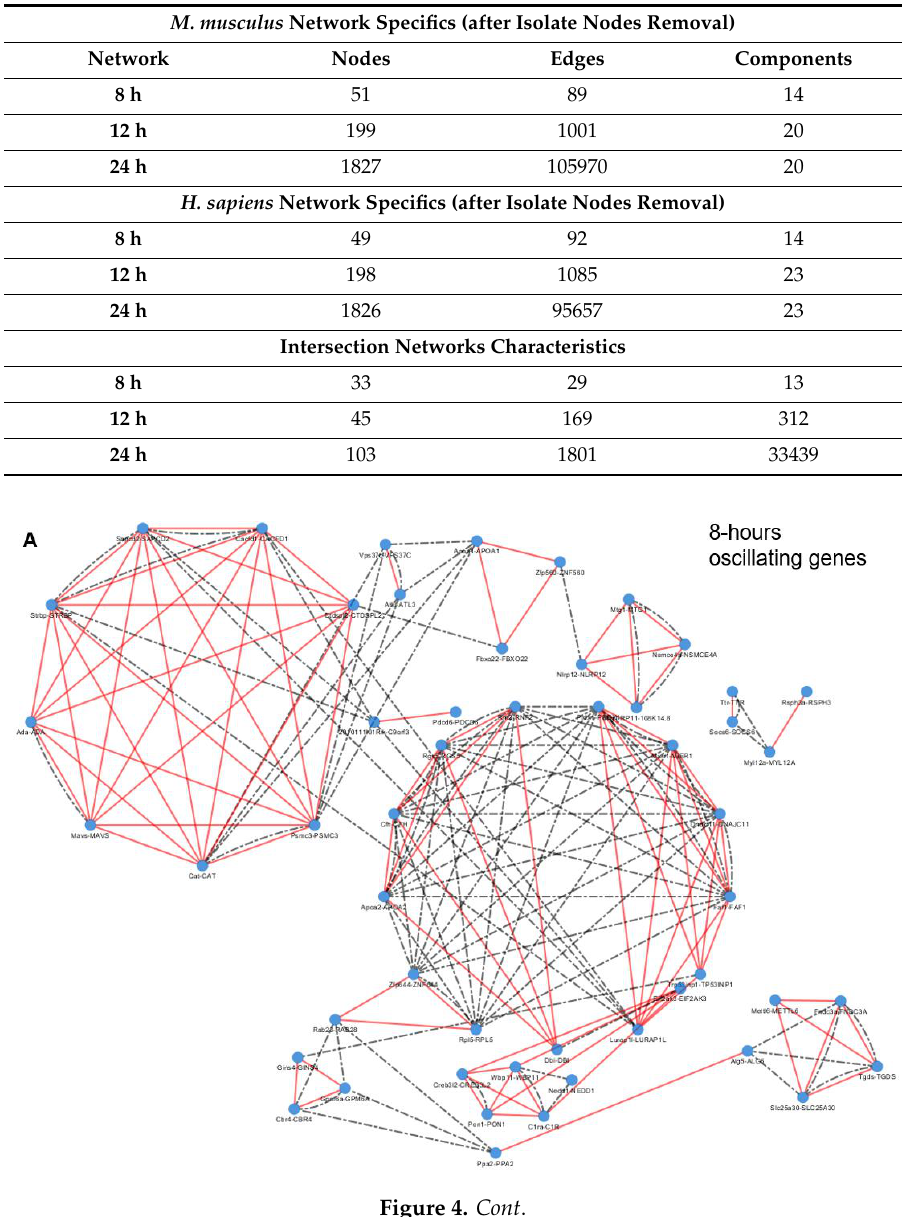
Table 2. Topological features of M. musculus and H. sapiens chromosomal co-localization networks created upon homology mapping of oscillating genes.